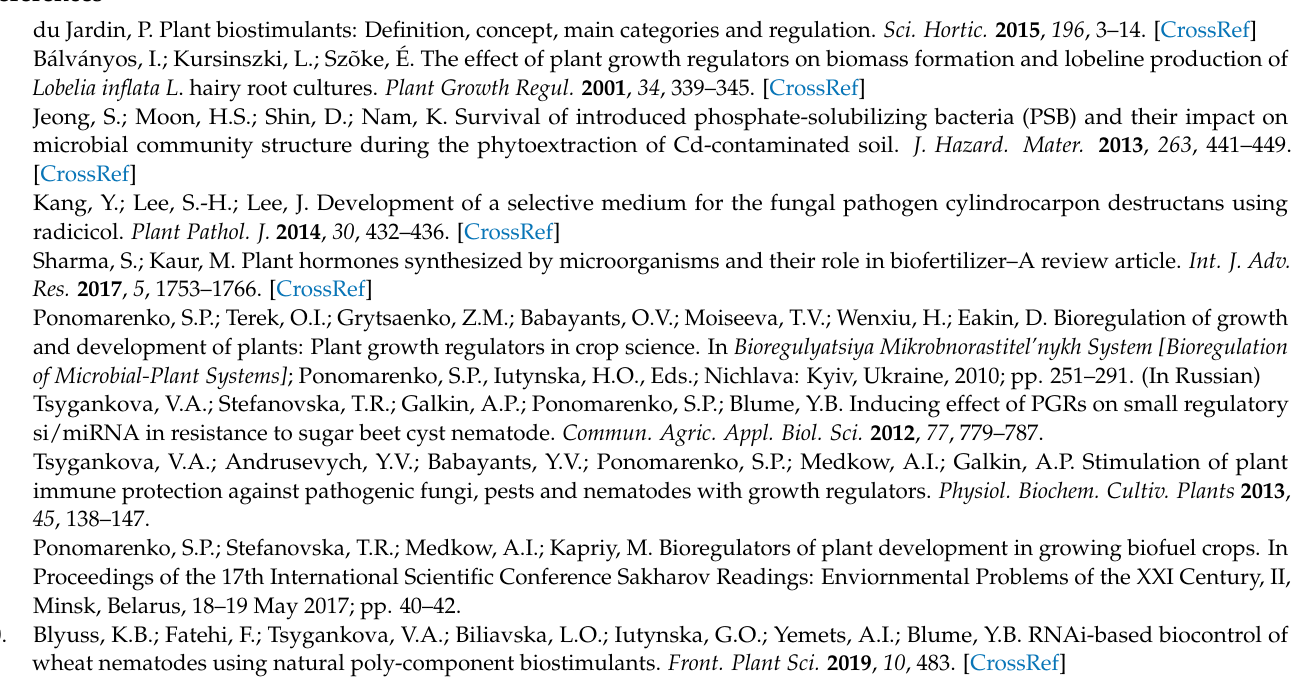
Figure S2. The effect of PGRs on shoot number ( a ) depending of soil’s type ( b ). Squares and circles show least square means. Vertical bars denote 0.95 confidence intervals; Figure S3. The effect of PGRs on root length ( a ) depending of soil’s type ( b ). Squares and circles show least square means. Vertical bars denote 0.95 confidence intervals; Figure S4. The effect of PGRs on stem’s length ( a ) depending of soil’s type ( b ). Squares and circles show least square means. Vertical bars denote 0.95 confidence